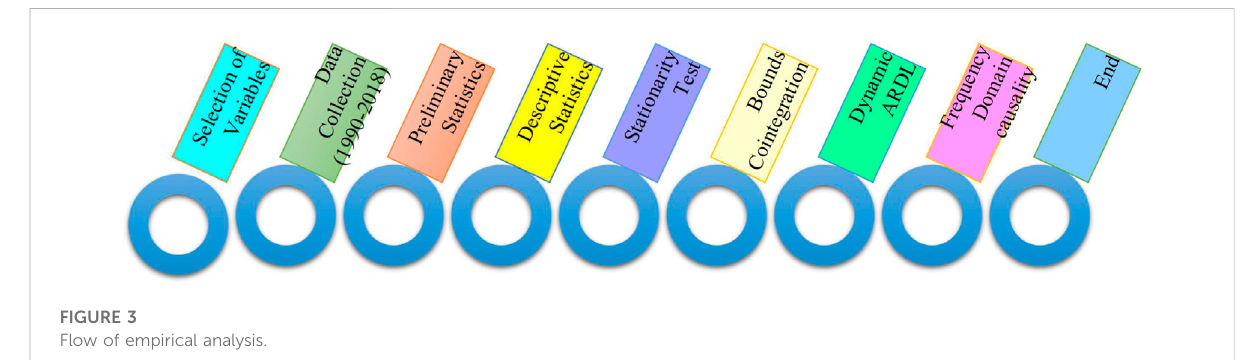
FIGURE 3 Flow of empirical